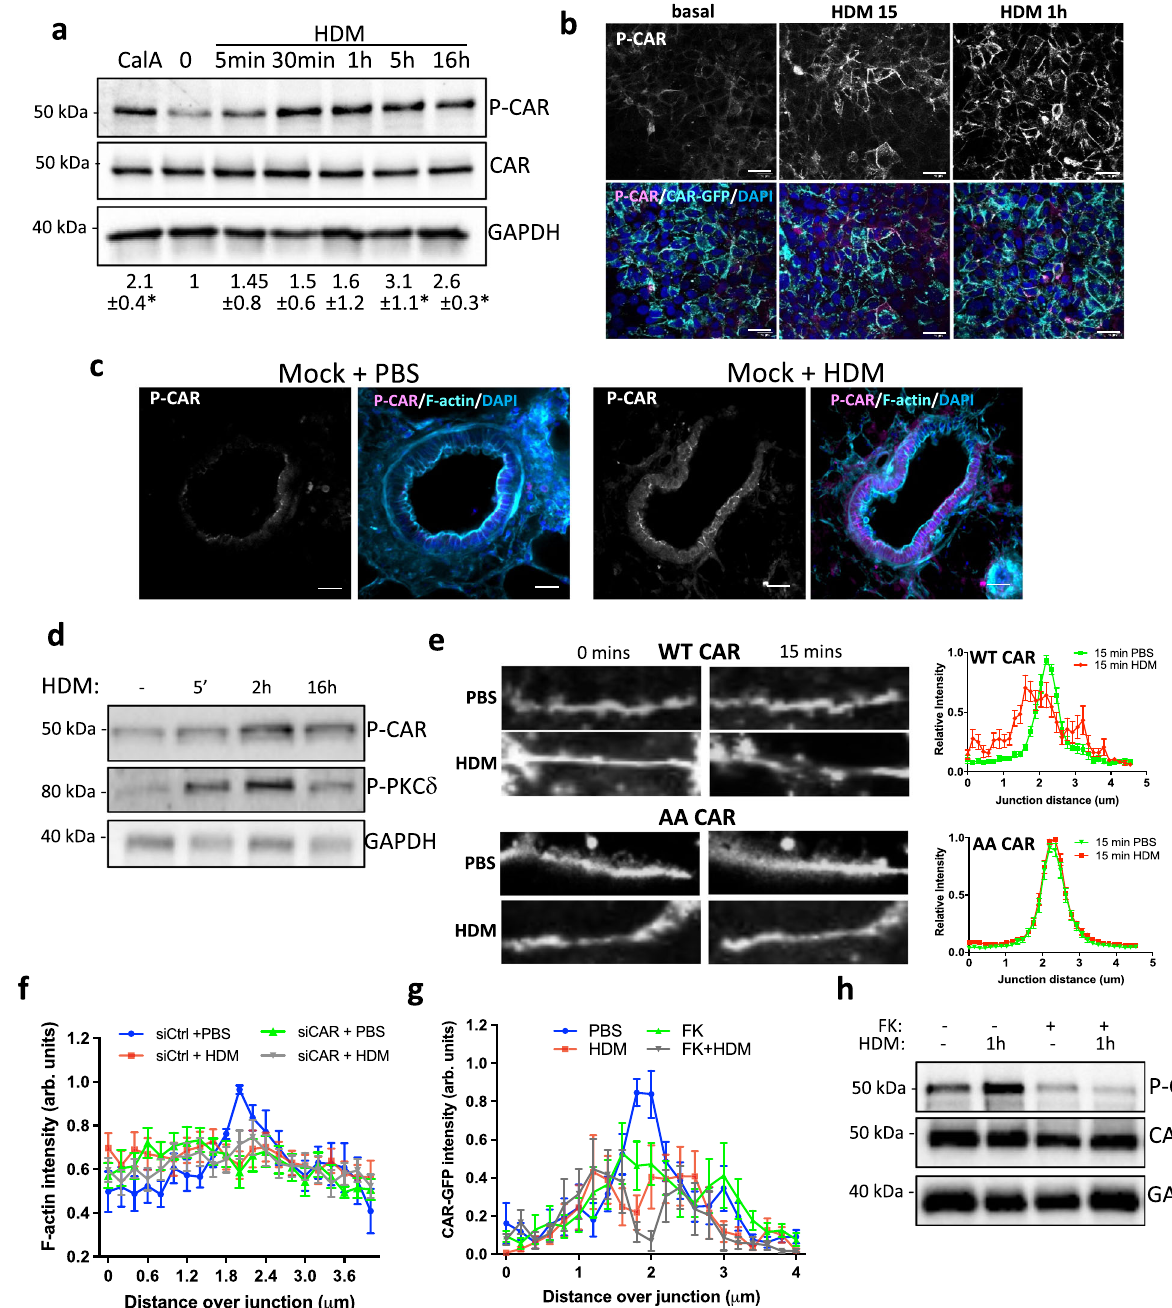
Fig.4|HDMtreatmentleadstophosphorylationandincreasedmobilityofCAR at junctions. a 16HBE CAR-GFP cells treated with Calyculin A (CalA) for 5min or with HDM for the indicated times. Representative western blots probed for CAR, T290/S293 phospho CAR (P-CAR) and GAPDH. Quanti fi cation pf pCAR from three independent experiments is shown below. b Confocal images of CAR-GFP (green) 16HBEcells treated with HDM as indicated. Cells werestained forP-CAR(magenta) and DAPI (blue).Representative of 3 independentexperiments. Scale bars;50mm. c Confocal images of PLCS from Mock mice±HDM treatment over 5 weeks, fi xed andstainedforP-CAR(magenta),F-actin(cyan)andDAPI(blue).Scalebars;50mm. d 16HBEcellstreatedwithHDMforindicatedtimes,lysedandsubjectedtowestern blotting probing for P-CAR and P-PKC δ . Representative of 3 independent experi- ments. e Confocal images of live 16HBE CAR-GFP or AACAR-GFP cells treated with